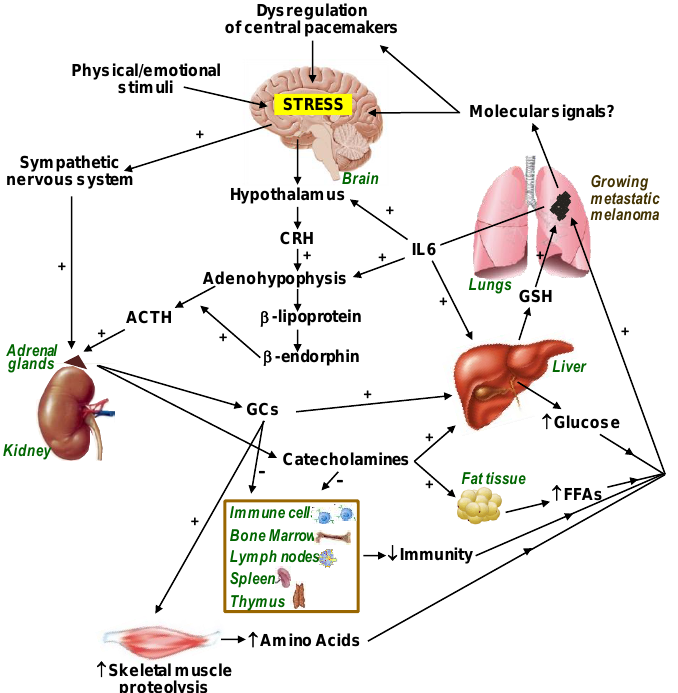
Figure 1 . Pathophysiology of Stress in Metastatic Melanoma. Stress-induced dysregulation of cen- tral pacemakers and IL-6 (mainly from metastatic cells) favor the release of pituitary ACTH. IL-6 and catecholamines increase glutathione (GSH) release from the liver. Metastatic cell γ -glutamyl transpeptidase degrades plasma GSH, providing extra cysteine for GSH synthesis. GSH is a main physiological antioxidant involved in promoting metastases growth. Glucocorticoids (GCs) upreg- ulate the Nrf2-dependent defense system in metastatic cells. Stress hormones decrease the immune response and facilitate the provision of nutrients to the growing metastases. Tissue-specific micro- environments or the influence of tumor innervation can also be decisive in the behavior of metastatic cells. ACTH, adrenocorticotropic hormone; CRH, corticotropin releasing hormone; AAs, amino ac- ids, FFAs, free fatty acids.